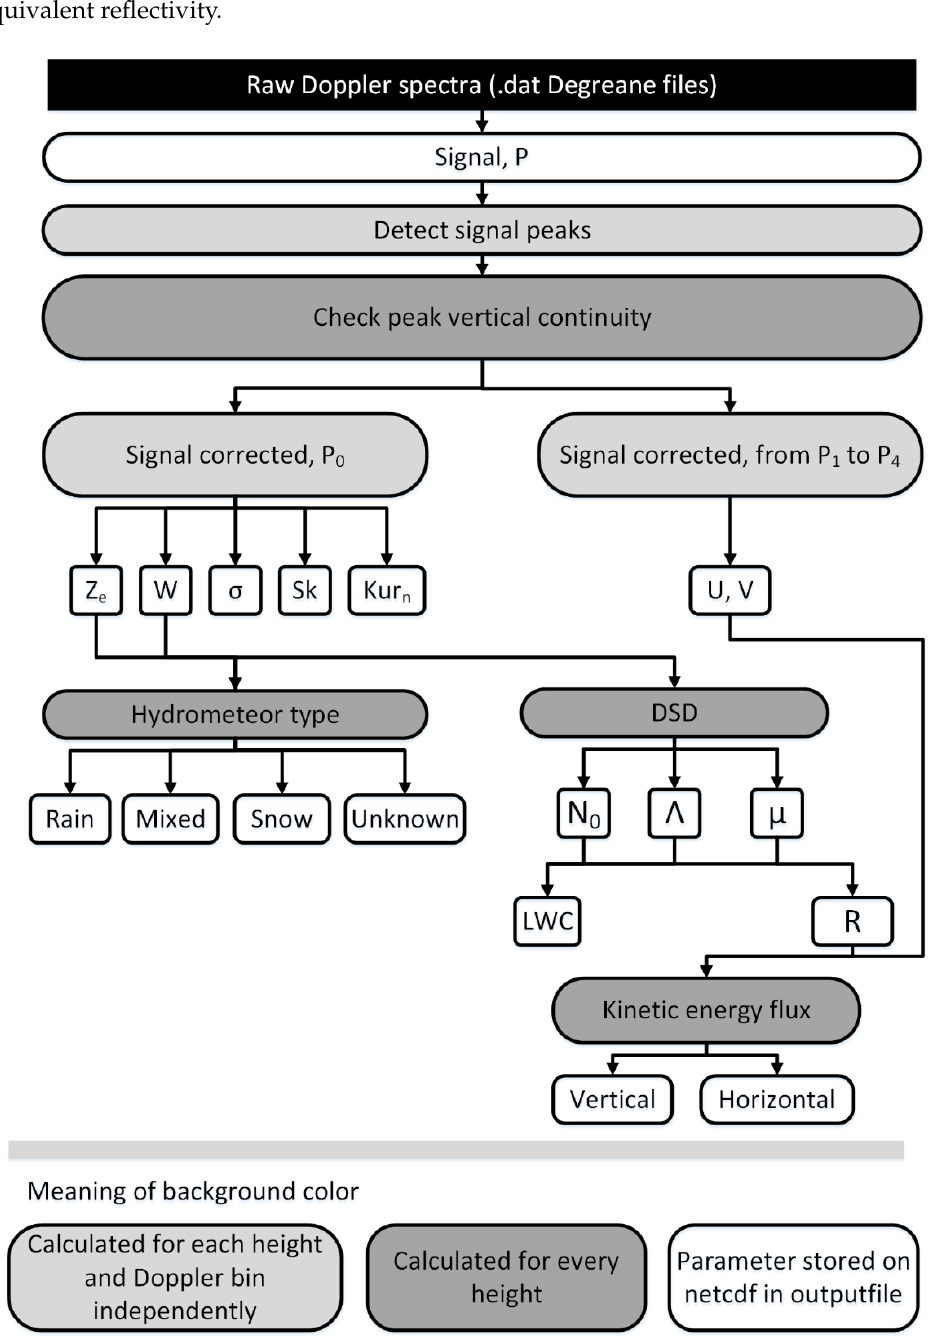
Figure 3. Flow diagram of the UBWPP Wind Profiler processing of raw Doppler spectra and output variables, see in the text for the explanation of the parameters appearing in the diagram.